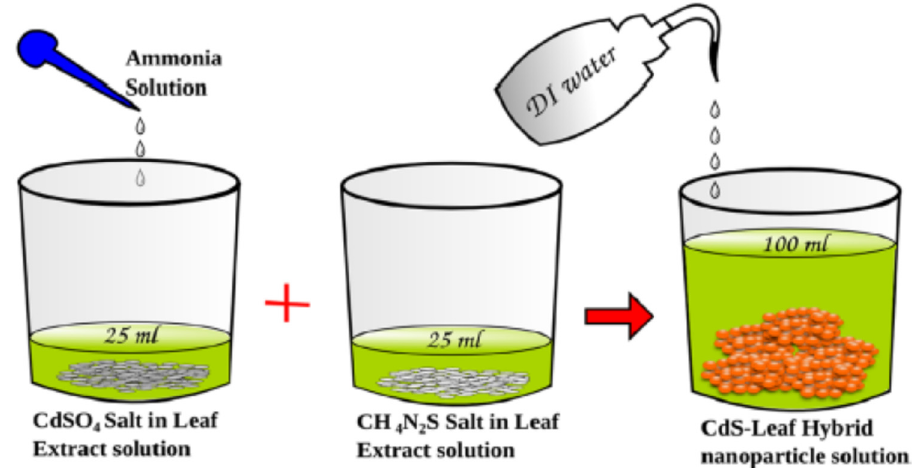
Figure 10: An example of the cards - GS hybrid nanoparticle production [ 59 ] . Copyright © 2021; American Chemical Society.